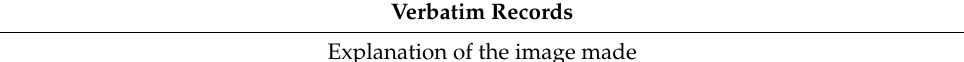
Table 7. Selection of verbatim records from answers about the photographs and personal reflections and